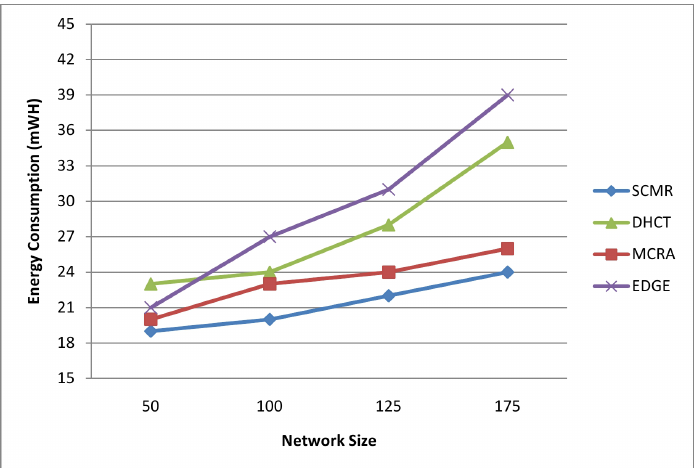
Figure 10. Energy Consumption of Our Protocol Compared with Other